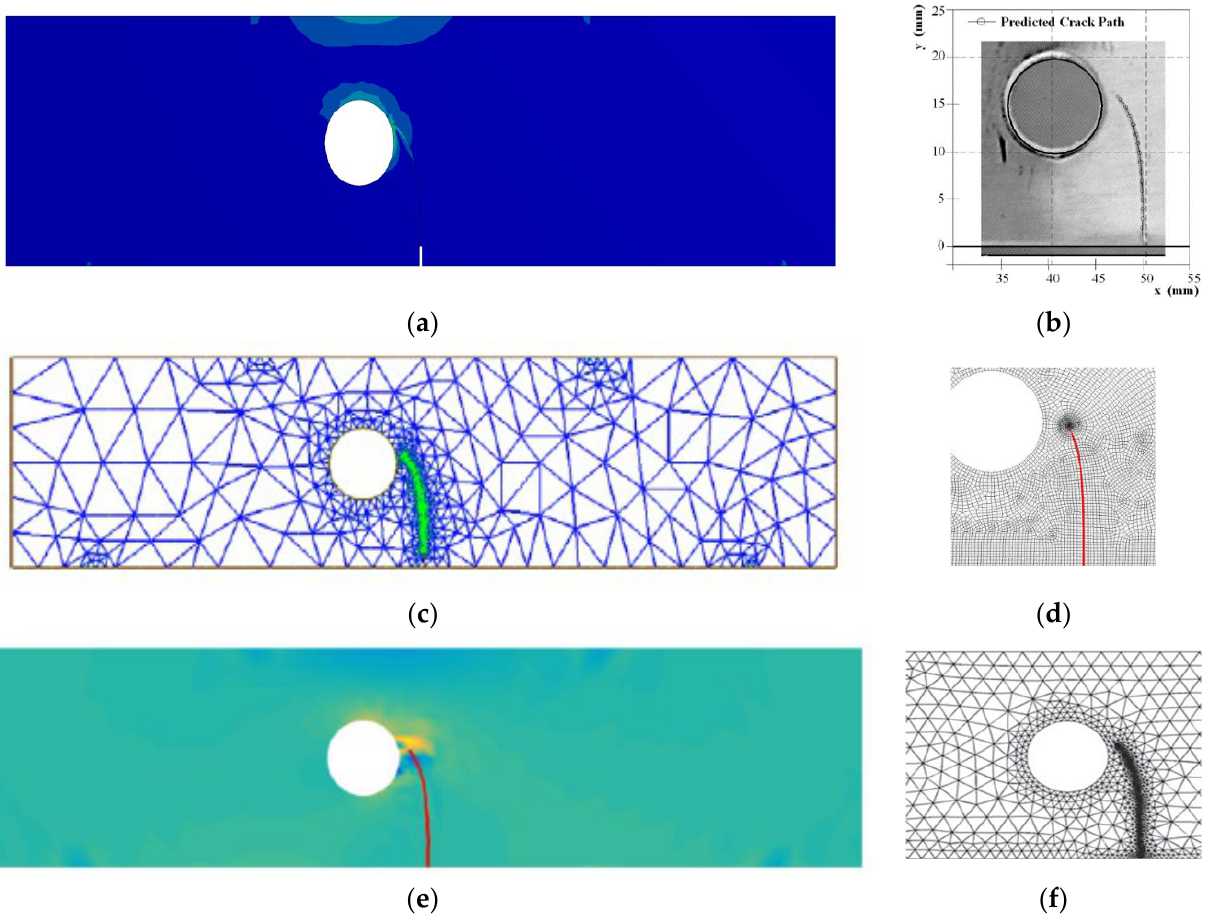
Figure 15. A comparison of the four point bending beam’s crack growth path, ( a ) present study, ( b ) experimental results [48], ( c ) numerical [49], ( d ) numerical [50], ( e ) numerical [47], ( f ) numerical [27].